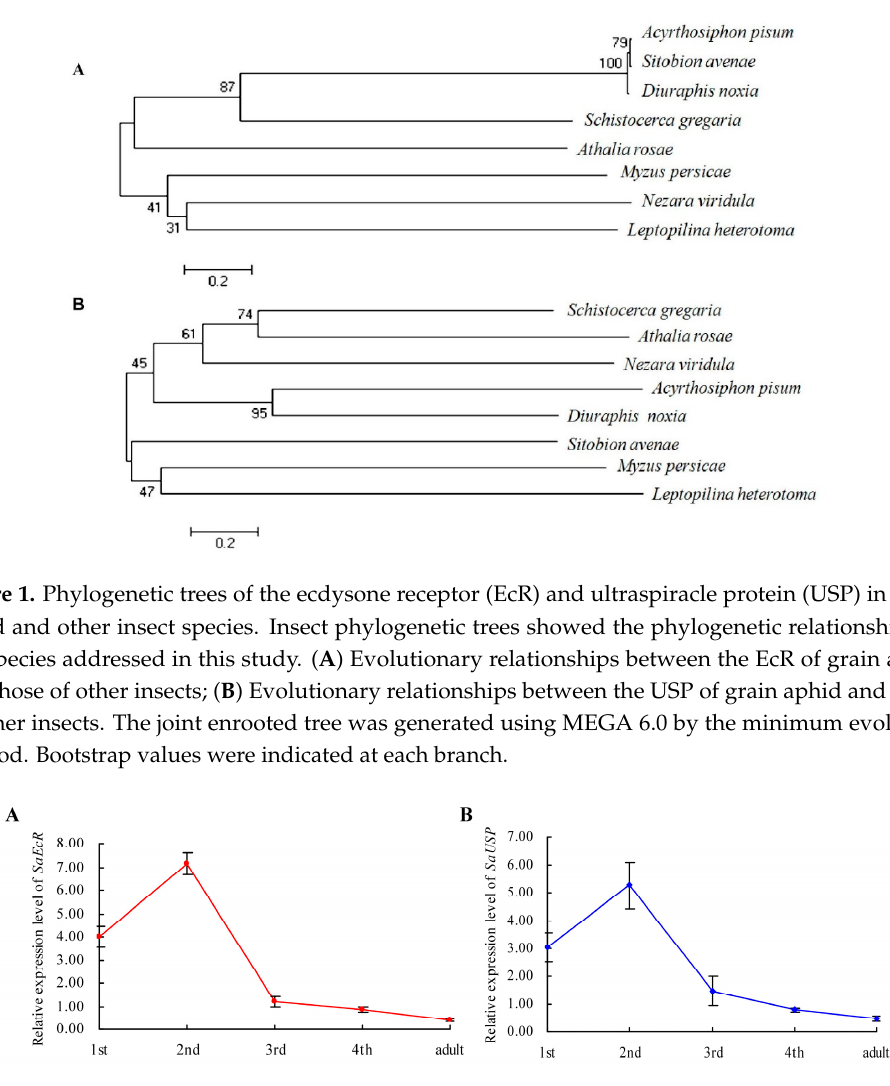
Figure 2. The expression profiles of SaEcR ( A ); and SaUSP ( B ) at different developmental stages in grain aphid. SaEcR and SaUSP transcripts accumulated at various levels throughout the aphid development. The expression of both SaEcR and SaUSP were simultaneously up-regulated and peaked in the second instar nymphs, then decreased gradually. Bars represent mean values ± SEM (standard error of the mean) of three independent biological replicates, each with a pool of 10 individual aphids.